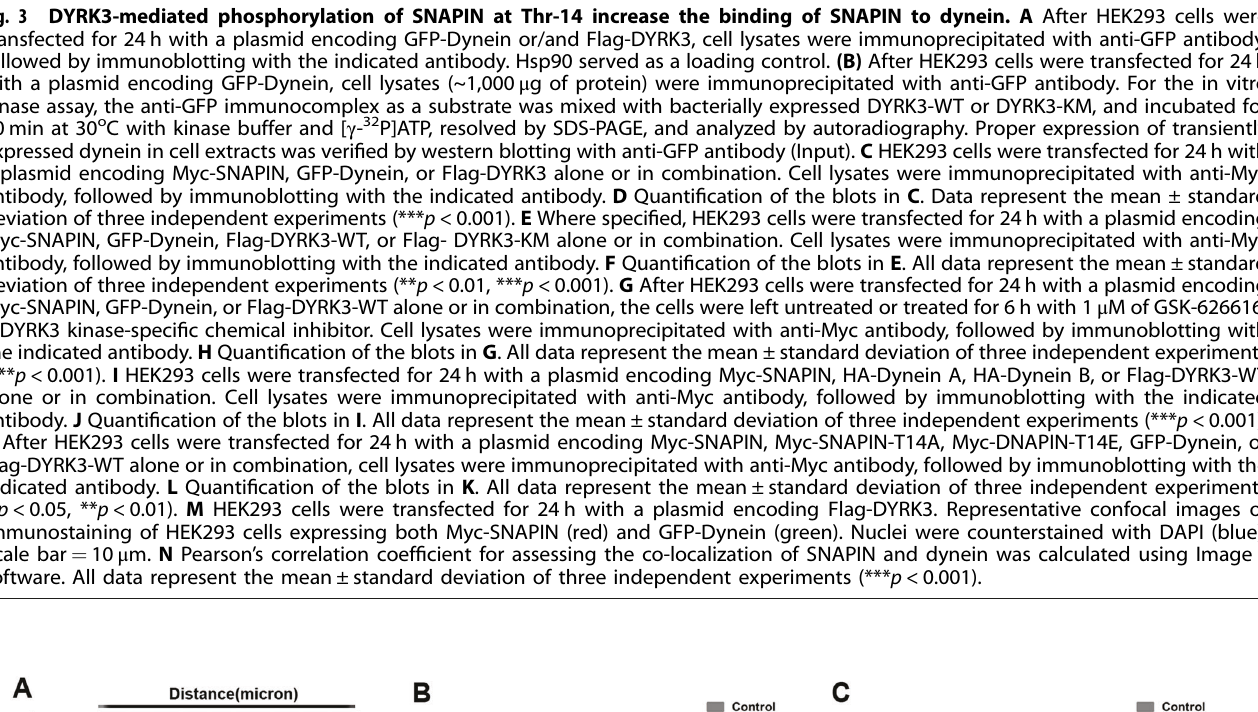
Fig. 4 Phosphorylation of SNAPIN at Thr-14 regulates mitochondrial retrograde transport in mouse cortical neurons. A Representative kymographs of mitochondrial movement in mouse primary cortical neuron transfected with SNAPIN-WT, SNAPIN-T14A, or SNAPIN-T14E. The movement of mitochondria is shown. Scale bar = 10 μ m. B Average motility of mitochondria. Motility is presented as the percentage of motile mitochondria over total mitochondria. Anterograde and retrograde motility were assessed, respectively ( n = 29 axons for control [CTL], n = 33 axons for SNAPIN wild-type [WT], n = 34 axons for SNAPIN-T14A mutant, and n = 31 axons for SNAPIN-T14E mutant). All results are presented as the mean ± SEM. (n.s., not signi fi cant) analyzed with Student ’ s t test. C Average velocity of motile mitochondria. Anterograde and retrograde velocity were assessed separately. All results are presented as the mean ± SEM. * p < 0.05, ** p < 0.01 and from Student ’ s t test. vesicular lumen but increases upon extracellular exposure [24] (Fig. 5A). When the siRNA-transfected neurons were stimulated with 900 APs at 20 Hz to completely deplete the recycling pool, the fl uorescence intensity of Syp-pHl increased rapidly and decayed after stimulation, representing synaptic vesicle exocytosis and endocytosis, respectively (Fig. 5B). The heterogeneity of the total pool size among different boutons was compensated by normalization to the signal obtained after treatment with NH 4 Cl, which reveals the total vesicle pool size of the given boutons. The peak intensity of Syp-pHl in the sample with SNAPIN- knockdown